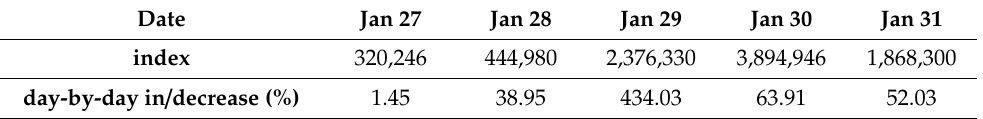
Table 10. WeChat Index of day-on-day comparison of postings; 2020 banner